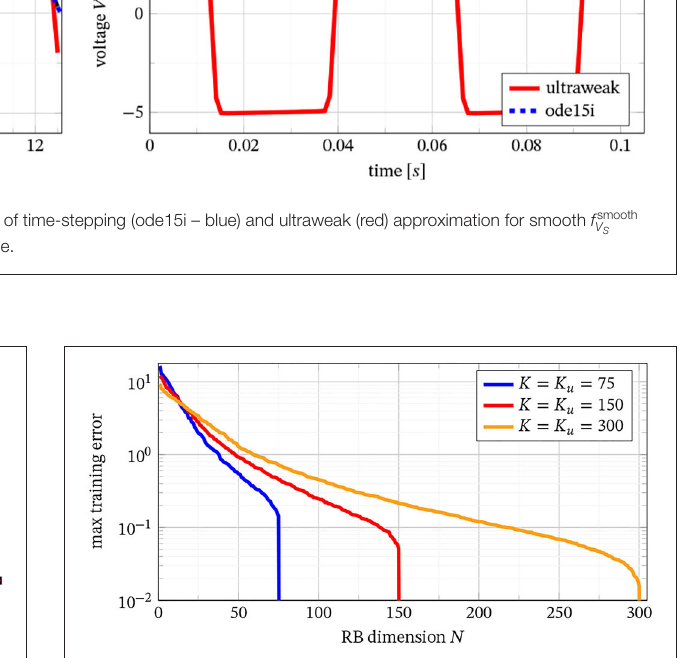
/ k x ∗ k L and relative error estimator 2 2